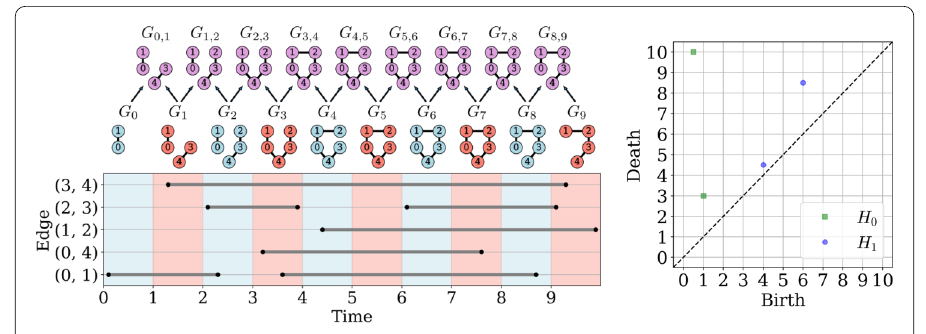
Figure 5 Example zigzag persistence applied to a simple temporal graph with temporal information stored for each edge as intervals. (Left) Edge intervals with sliding windows highlighted (alternating blue-red) with corresponding graphs and union graphs above. (Right) Zigzag persistence diagram for both H 0 and H 1 . The birth and death of a feature is encoded as the midpoint of the interval where the event happened